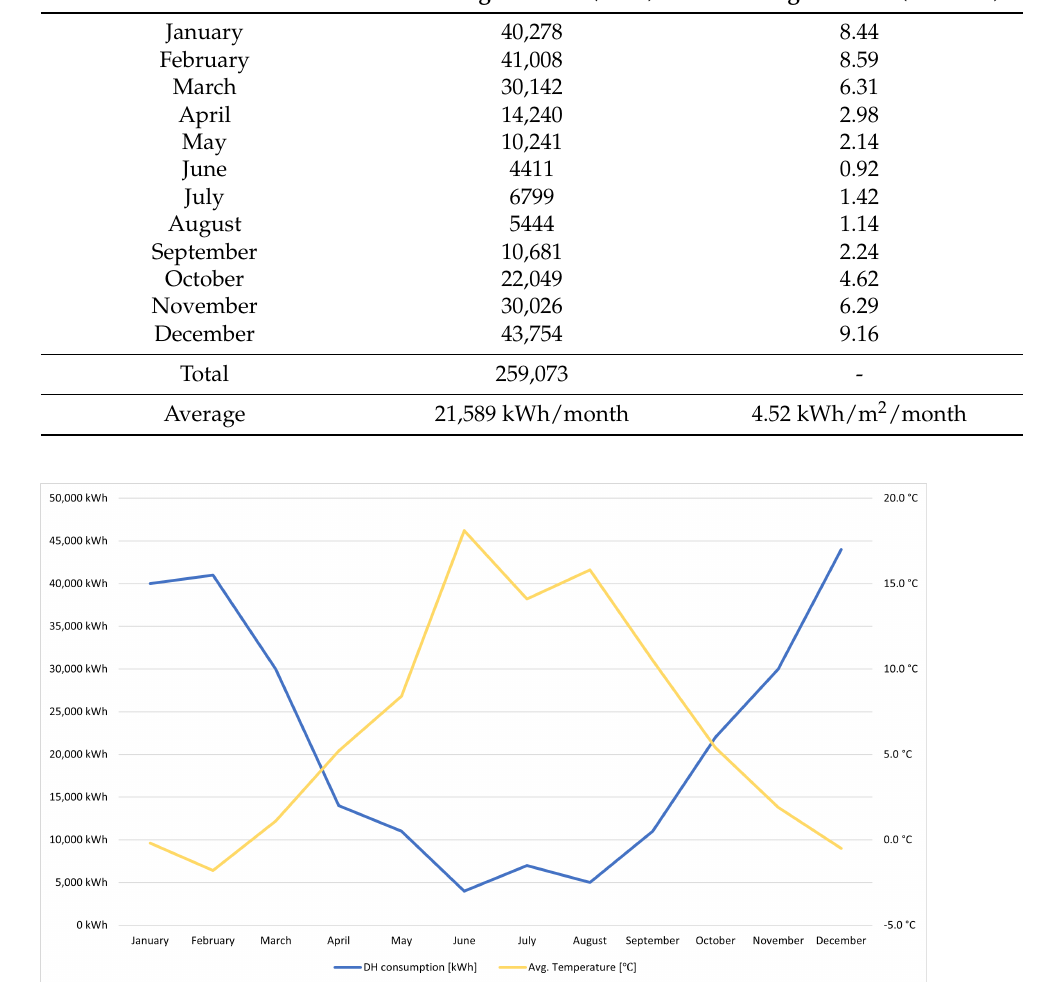
Figure 6. District heating delivered with the correlating mean